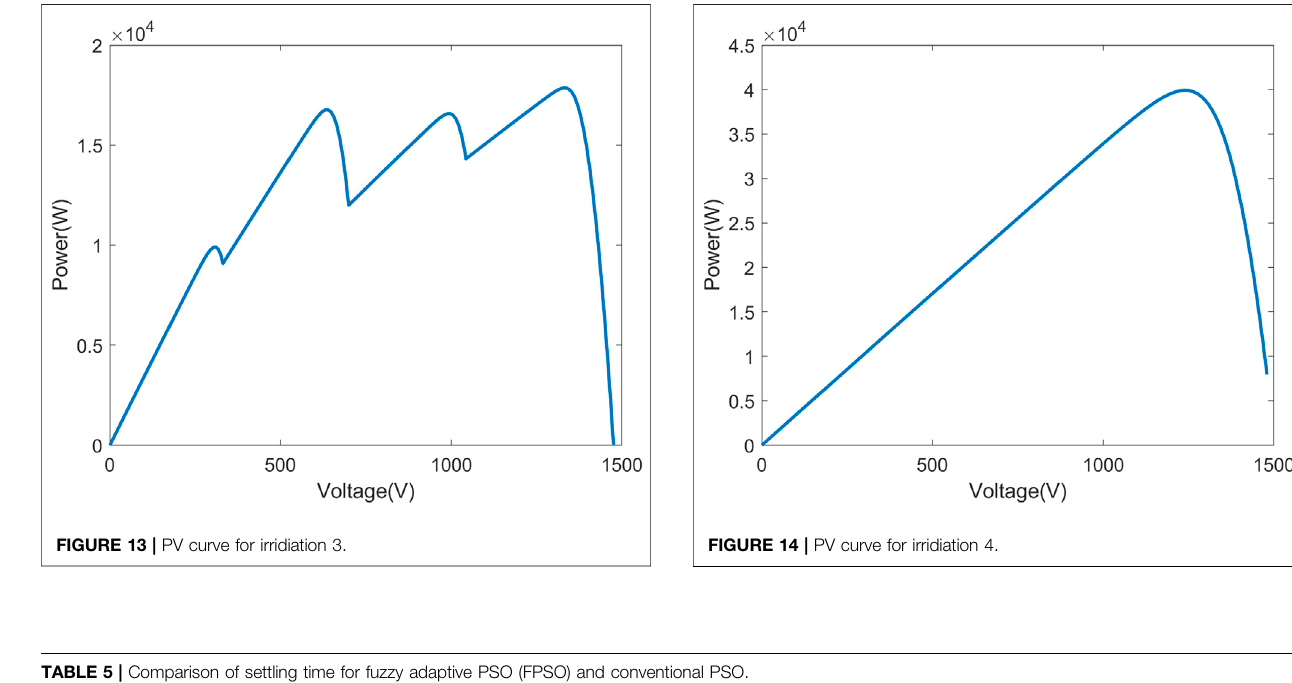
TABLE 5 | Comparison of settling time for fuzzy adaptive PSO (FPSO) and conventional PSO. Settling Time(s)